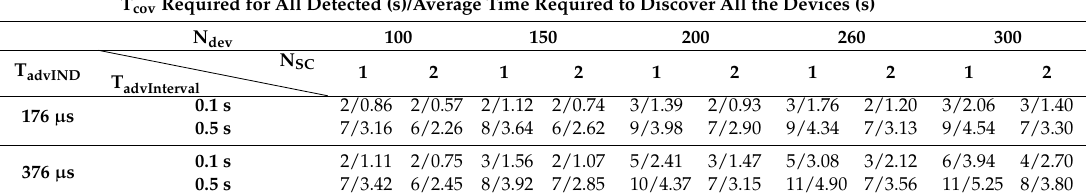
Table 4. Interrupted scannable undirected advertisement scheme. T cov required for detecting all the devices with 100% probability vs average required to discover all the devices, for one (N sc = 1) and two (N sc = 2) scanners.